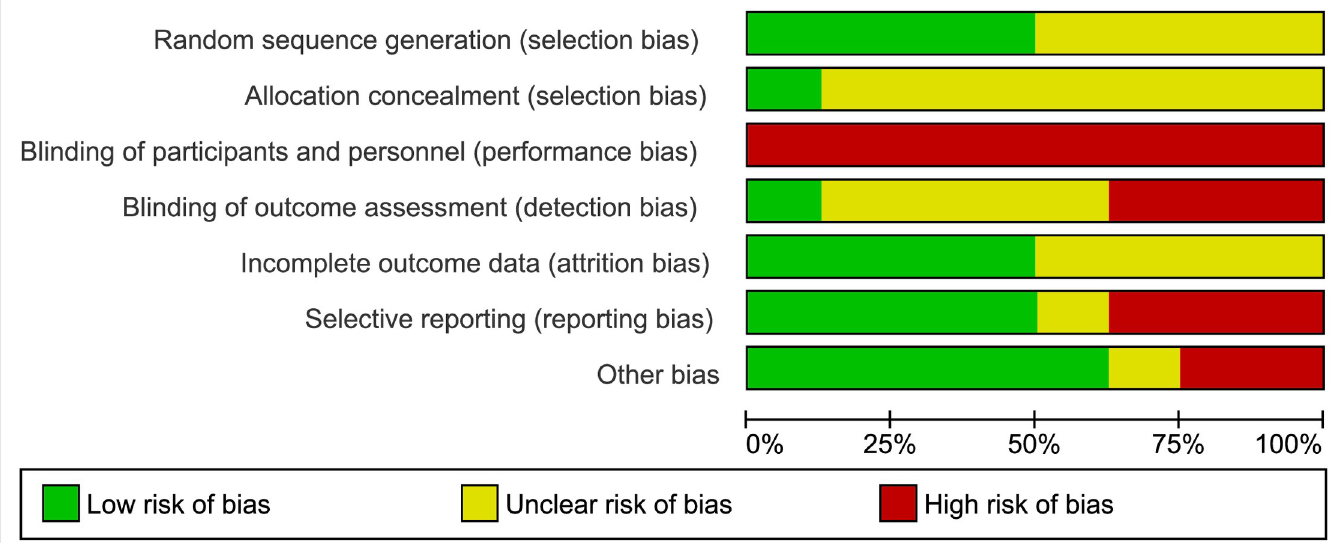
PLOS ONE | https://doi.org/10.1371/journal.pone.0268512 May 18,